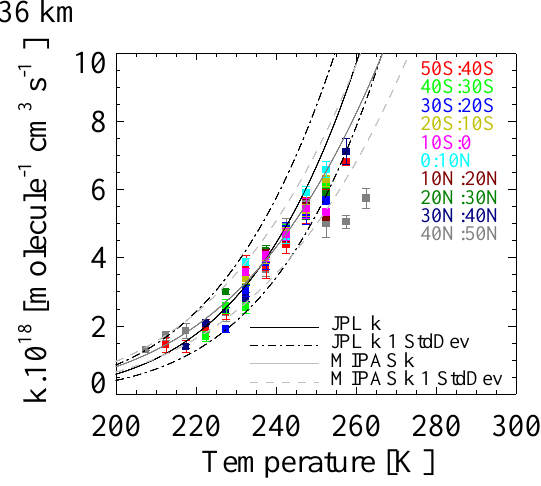
Fig. 8. As in Fig. 7 but at Fig. 7. As in Fig. 6 but at 36 km.